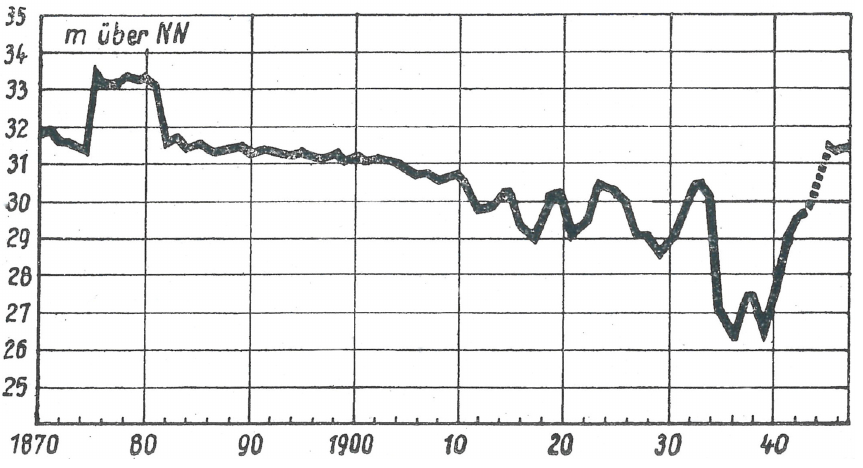
Figure 3. Graph of groundwater levels in meters above sea level in the centre of Berlin, 1870–1947 ( adapted from Ref. [72]) (p. 42).